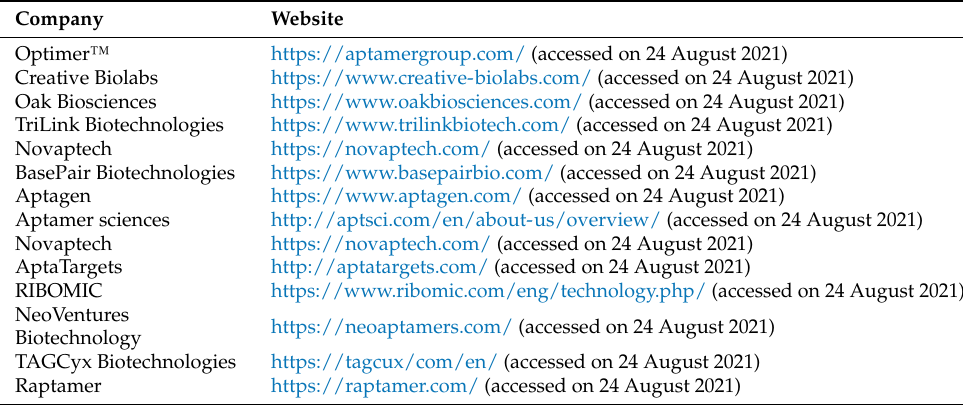
Table 1. Examples of aptamer development